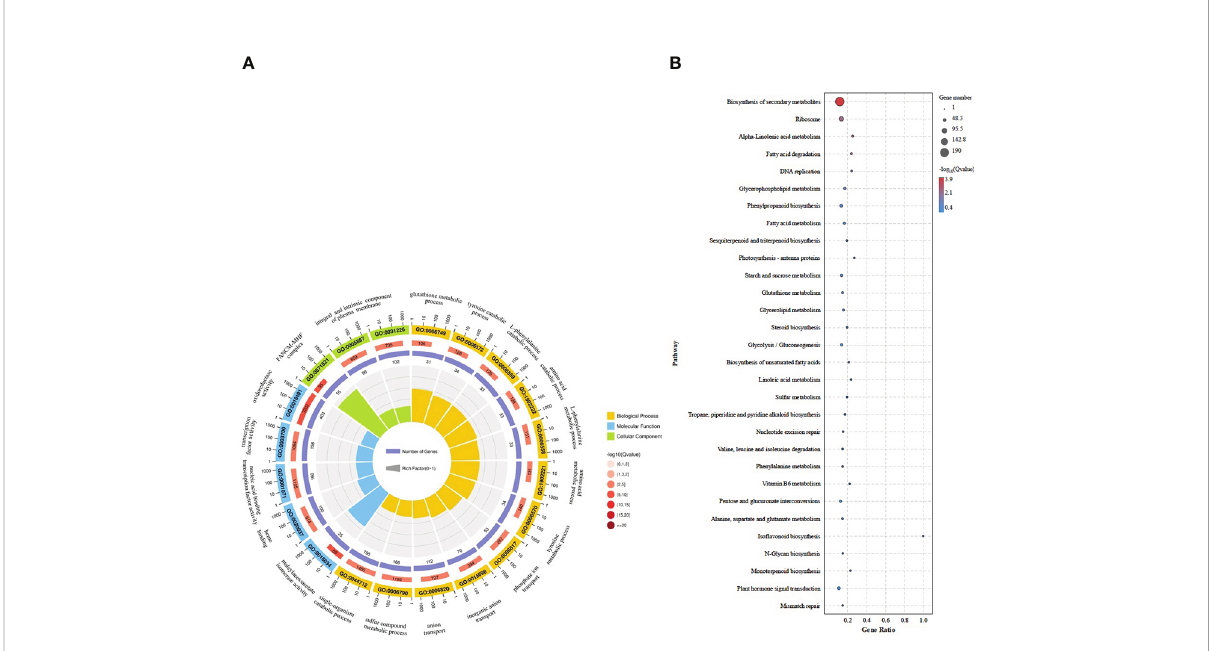
FIGURE 2 The GO (A) and KEGG (B) analysis of the DEGs in BXGZ-Cd vs